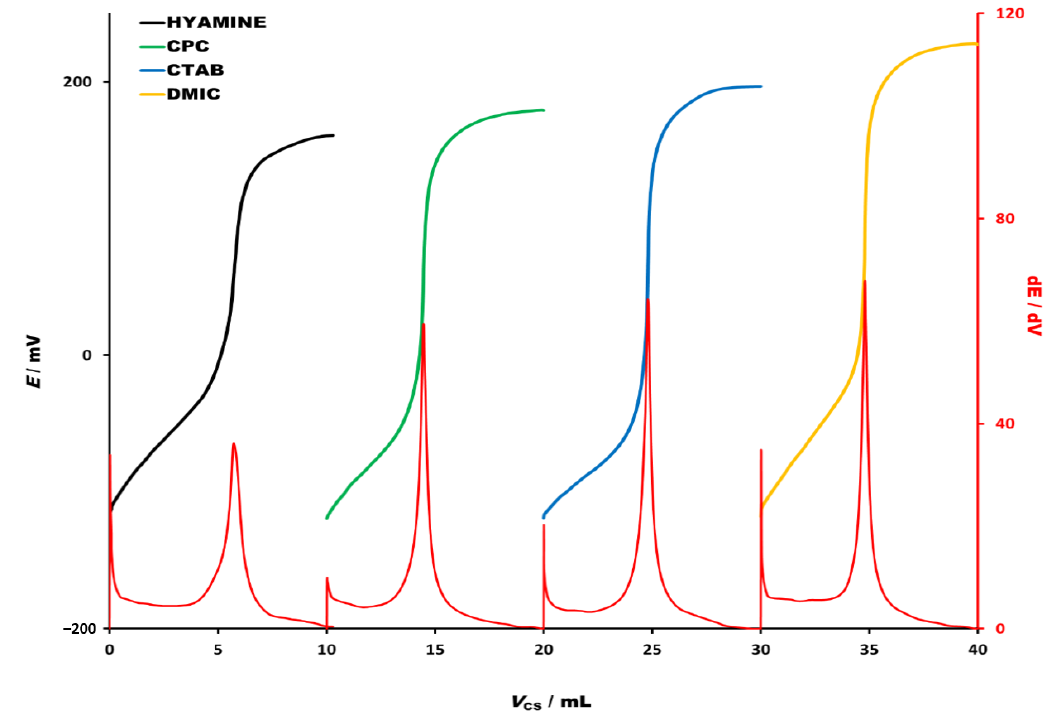
Figure 2. Potentiometric titration curves for titration of SDS (4 × 10 − 3 M) with four different cationic surfactants (4 × 10 − 3 M) used as a titrant: Hyamine 1622 (black line), CPC (green line), CTAB (blue line) and DMIC (yellow line). Corresponding first derivatives are presented in red lines below titration curves. The titration curves and their first derivatives are rearranged for the sake of clarity.